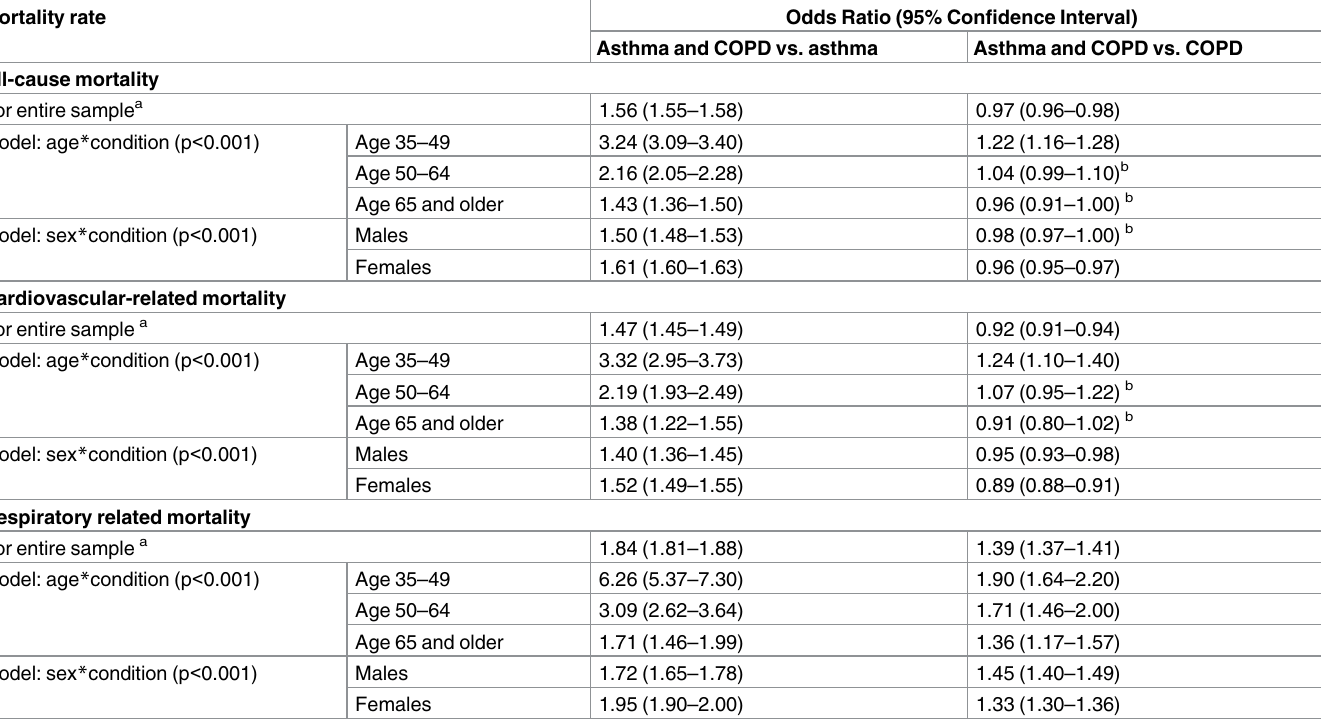
Table 2. The association between concurrent physician-diagnosed asthma and COPD compared to COPD or asthma with all-cause, cardiovascu- lar and respiratory mortality rates adjusted for time (calendar year), sex, and